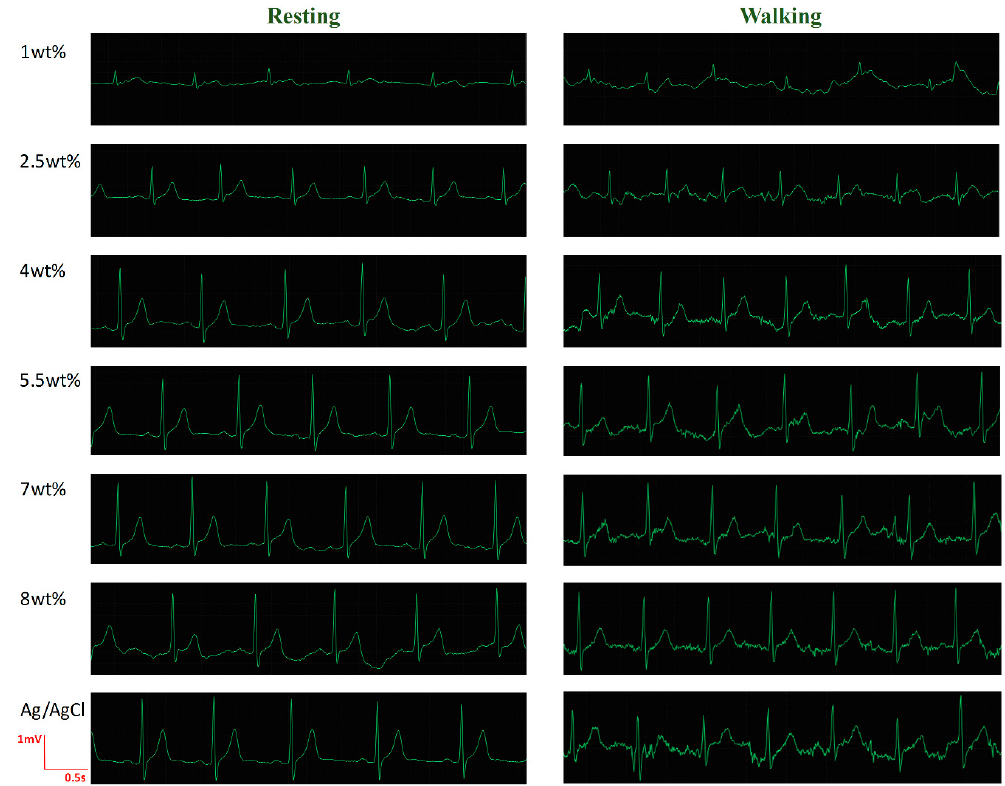
Figure 6. Electrocardiogram (ECG) signals of a male volunteer (age: 23) under resting and walking state for various MWCNT concentrations.